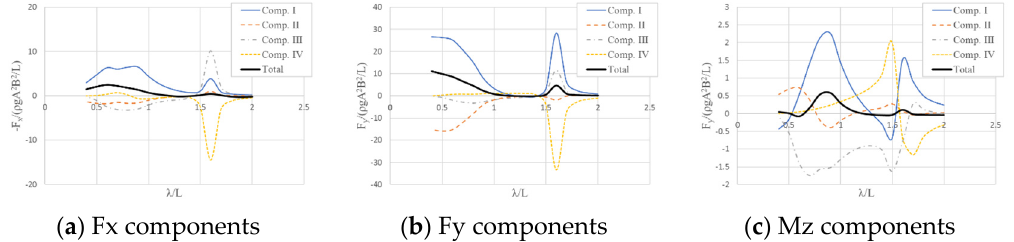
Figure 8. Components of wave drift force on KVLCC2: V = 6 knots, H/L = 1/50, β = 120°.